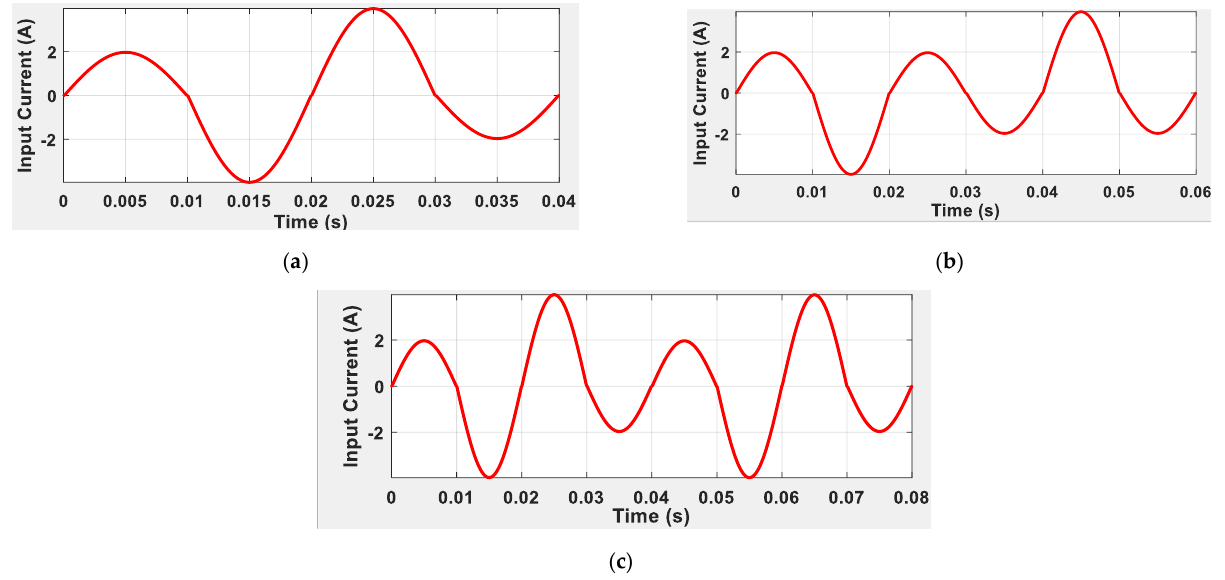
Figure 10. Waveforms of the input current with output voltage regulation capabilities for output frequency requirement: ( a ) one-half; ( b ) one-third; and ( c ) one-fourth.